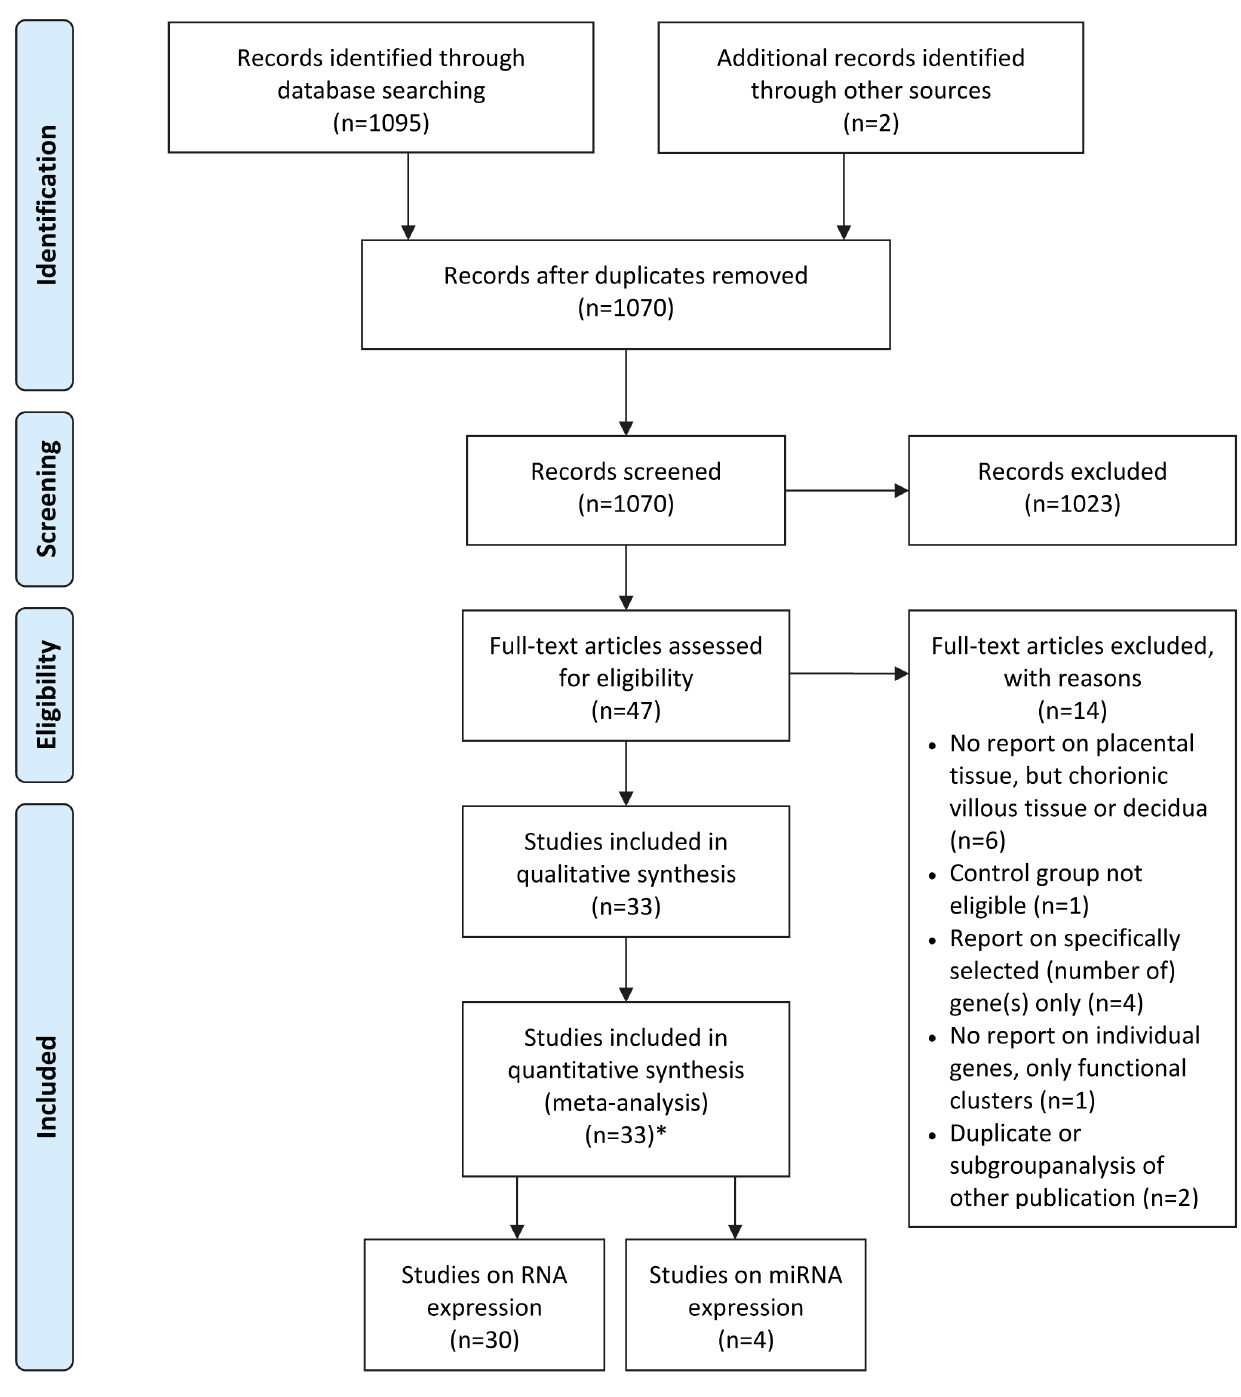
Figure 1. PRISMA flowchart summarizing the identification and selection of studies for inclusion in this systematic review.